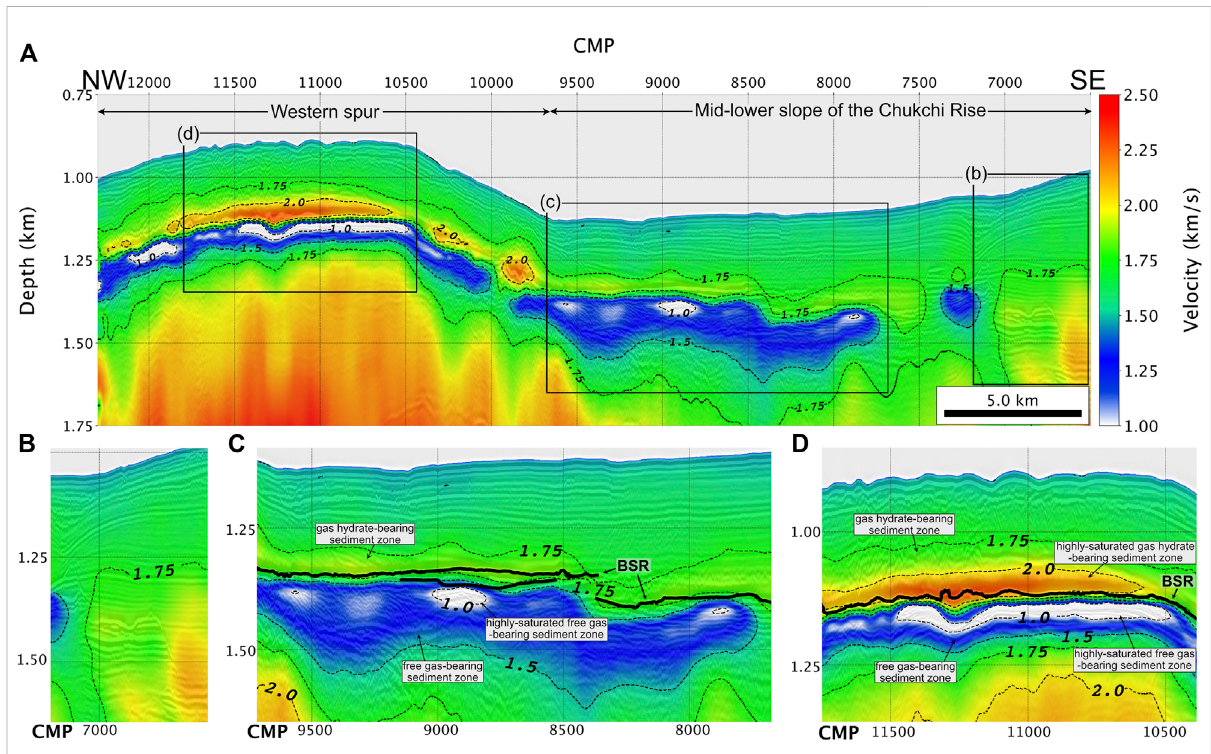
FIGURE 9 (A) Constructed P-wave velocity model overlaid with migrated seismic images using the IMVA of the MCS03 line. The analysis range is marked on the solid red line in Figure 1C. (B) – (D) is the enlarged velocity model: (B) absence area of the gas hydrate, (C) mid-lower slope of the western continental margin, and (D) crest of the western spur